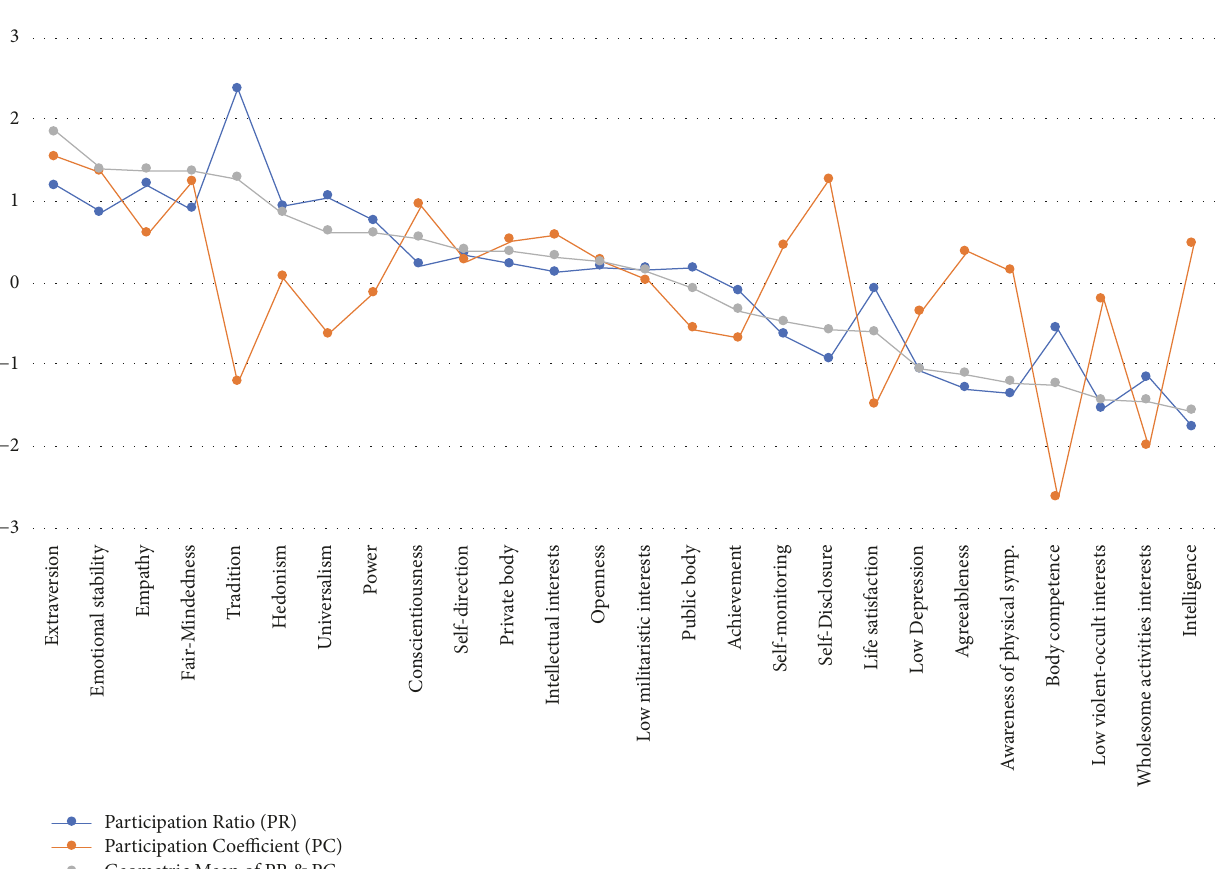
Figure8:Centralitymeasures3:participationratio(thevaluesofgeometricmeansforEmpathyandExtraversionarehigherthanbothPRand PC. This is due to standardization of each measure. The plots with raw scores are shown in SM, Section 9, Figure 10.) ( 𝛼 = 0.5 ), participation coefficient, and their geometric mean (standardized values).